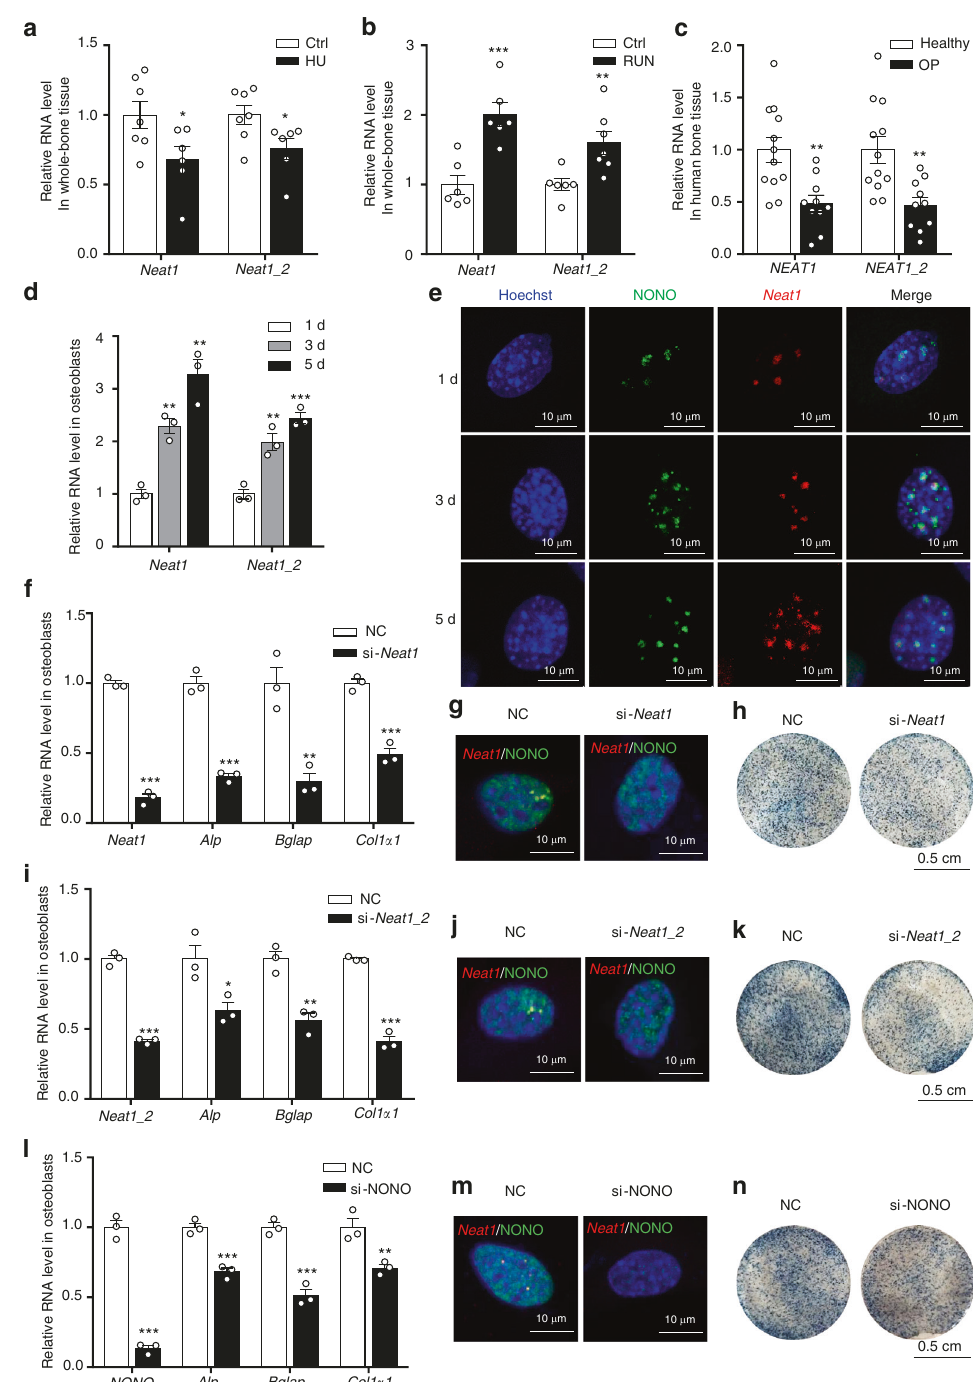
Fig. 2 Osteoblast function is closely correlated with Neat1 expression and paraspeckle formation. a Analysis of total Neat1 and Neat1_2 expression in whole-bone tissue from the control mice ( n = 7) and mice with hindlimb unloading ( n = 6). b Total Neat1 and Neat1_2 expression in whole-bone tissue from control ( n = 6) and mechanically loaded ( n = 6) mice. c The expression of total NEAT1 and NEAT1_2 in the bone tissue of healthy controls ( n = 12) and patients with OP ( n = 10). d The expression of total Neat1 and Neat1_2 in the process of osteoblast differentiation. The experiment was repeated for more than three times. e Representative images of confocal observations of paraspeckles during osteoblast differentiation. f Analysis of the expression of the osteogenic marker genes Alp , Bglap and Col1 α 1 after Neat1 knockdown. Representative results of three independent experiments are shown. g Representative FISH images of paraspeckles in osteoblasts upon Neat1 knockdown. h Analysis of ALP staining in primary osteoblasts after Neat1 knockdown. i Expression of the osteogenic marker genes Alp , Bglap and Col1 α 1 after Neat1_2 knockdown. The experiment was repeated for more than three times. j Representative FISH images of paraspeckles in osteoblasts upon Neat1_2 knockdown. k Representative ALP staining images of the control and Neat1_2 knockdown osteoblasts. l Analysis of the expression of the osteogenic marker genes Alp , Bglap , and Col1 α 1 after paraspeckle NONO knockdown. Representative results of three independent experiments are shown. m Representative FISH images of paraspeckles in osteoblasts upon NONO knockdown. n Representative ALP staining images of control and NONO knockdown osteoblasts. Data represent three independent experiments. * P < 0.05, ** P < 0.01, *** P <